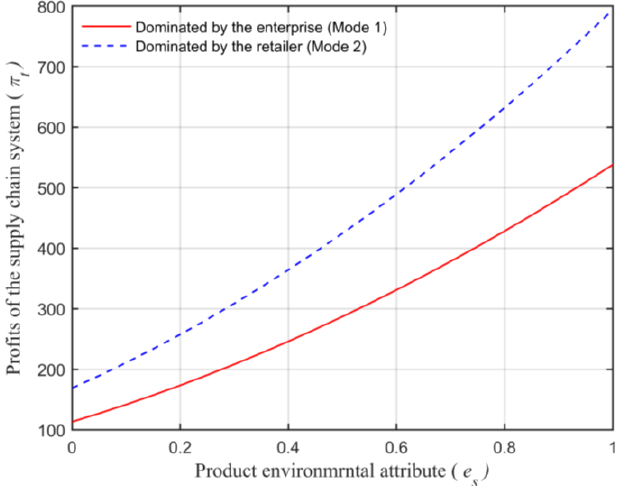
Figure 9. The relationship between the product environmental attribute and the supply chain system’s overall profits.